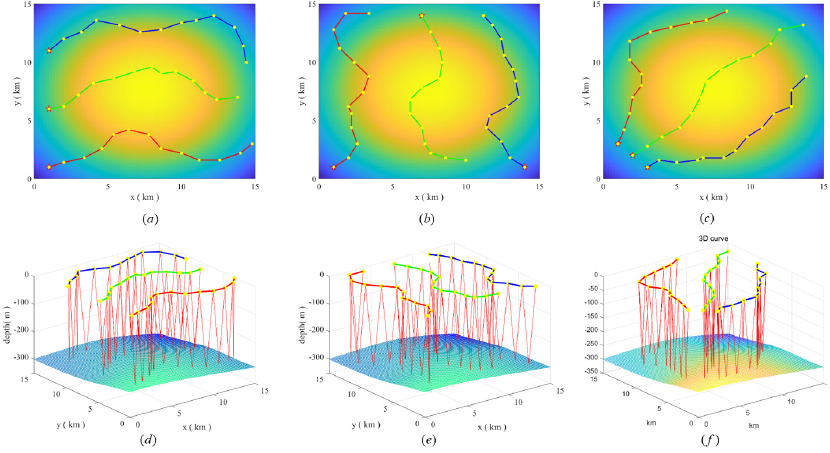
Figure 9. The MGCPP − ACO algorithm path planning results in scenario 3 (where ( a – c ) are 2D plane trajectories, and ( d – f ) are 3D space trajectories).